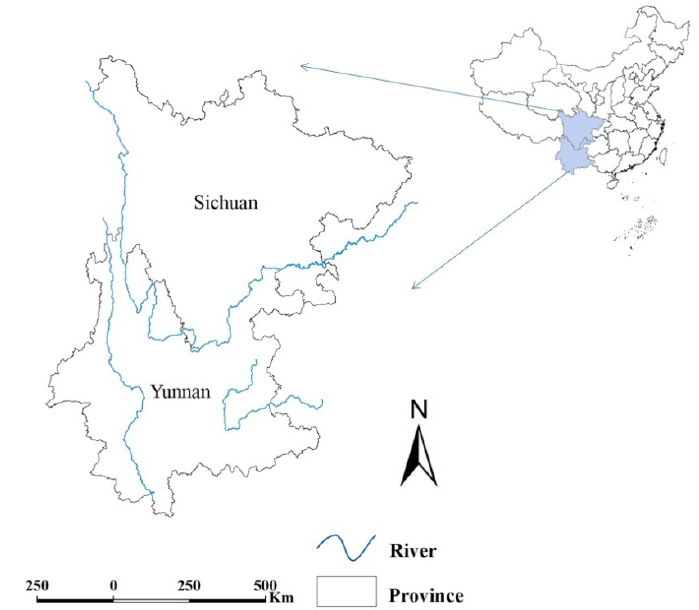
Figure 1. Location of Sichuan and Yunnan Province. Geographical rivers layer was overlaid. The map was created using the ArcGIS software (version 10.0, ESRI Inc., Redlands, CA,